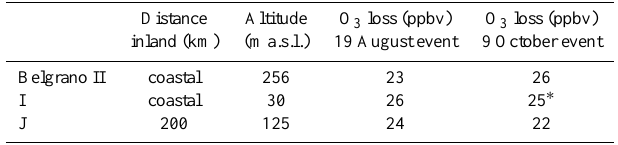
Table 3. As for Table 2, but now for a coastal and an inland site on the Filchner Ice Shelf (Site I and J respectively), as well as at a nearby coastal site (Belgrano